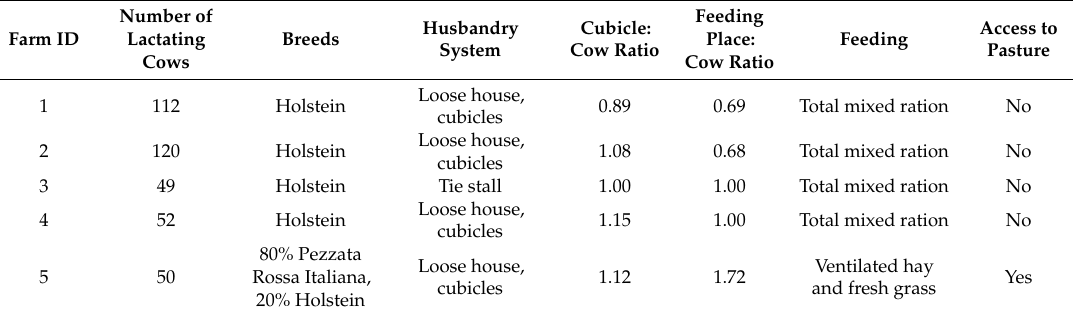
Table 1. Main characteristics of dairy farms involved in the